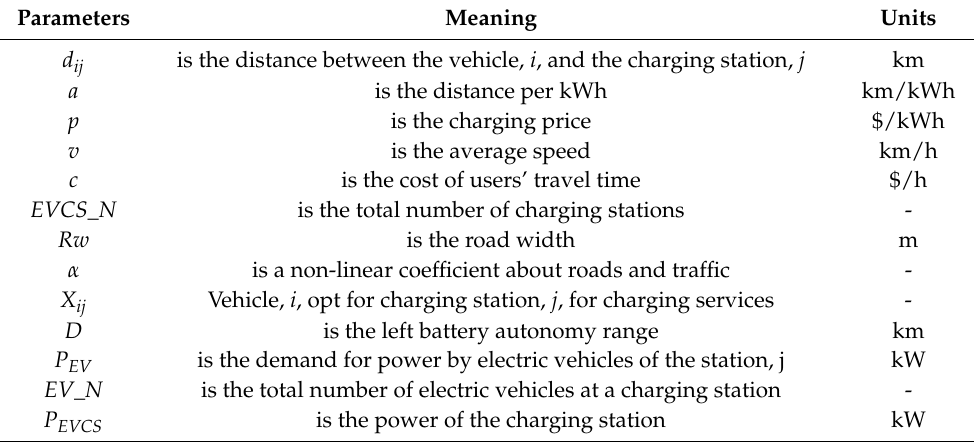
Table 2. List of GA